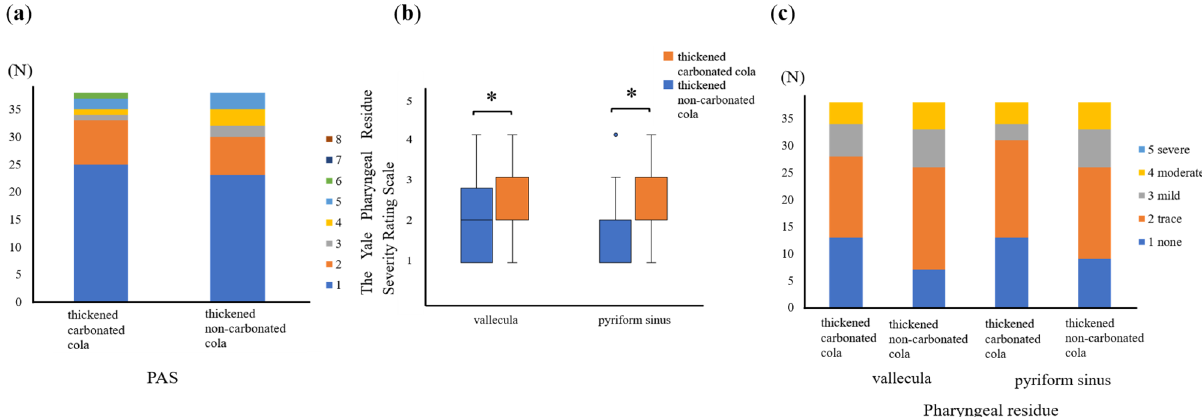
Figure 1. Comparison of swallowing dynamics between thickened carbonated and thickened non-carbonated cola. ( a ) Comparison of penetration/aspiration with thickened carbonated cola and thickened non-carbonated cola. ( b ) Boxplot comparing the amount of pharyngeal residue between thickened carbonated cola and thickened non-carbonated cola (* p < 0.05). ( c ) Bar graph comparing the amount of pharyngeal residue for thickened carbonated cola and thickened non-carbonated cola. PAS Penetration-Aspiration Scale.